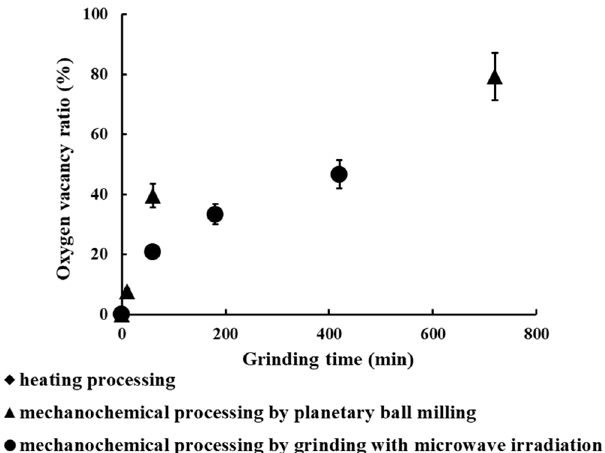
Figure 7. Relationship between grinding time and the oxygen vacancy ratio.